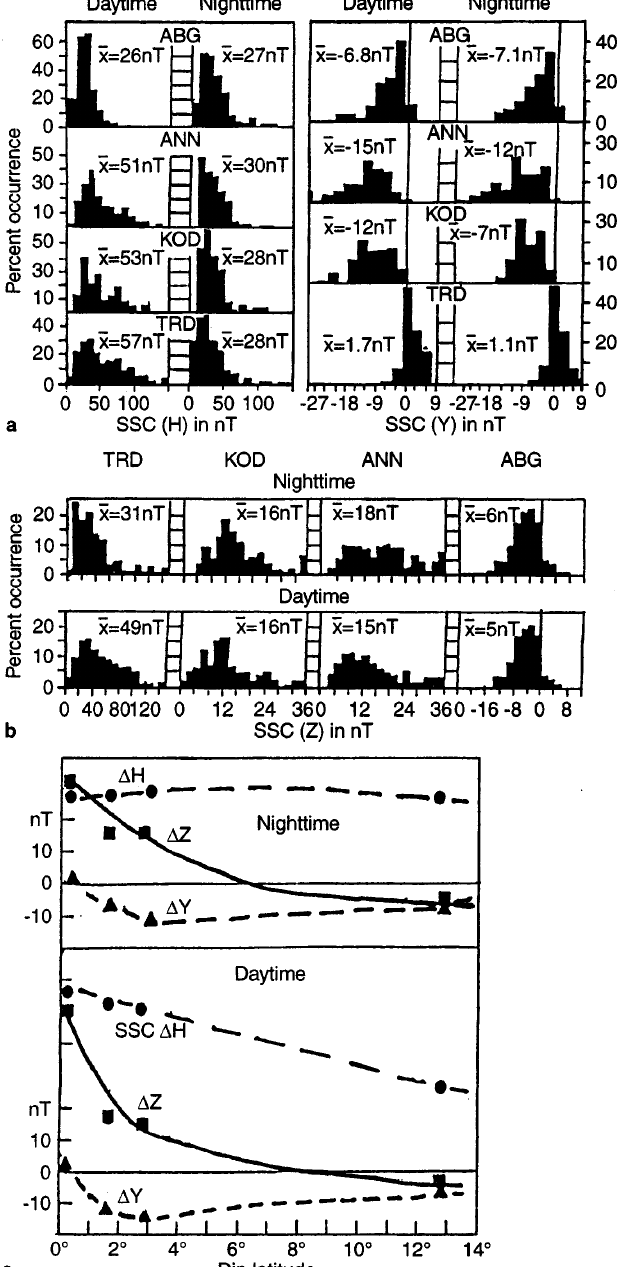
averaged for 1958–1992, c Latitudinal variations of mean D H, D Y, and D Z due to SSC occurring during daytime and nighttime. d Latitudinal variations of D H, D Y, and D Z during individual SSC events of daytime